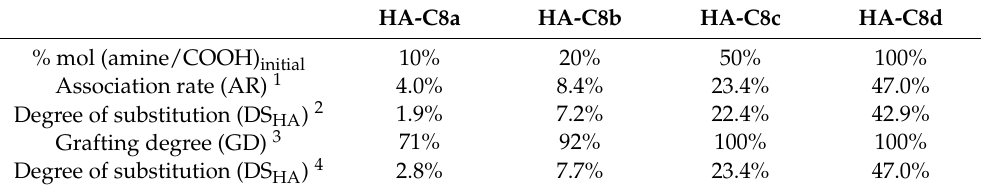
Figure 2. 1 H NMR spectra of octylamine functionalized HA: Hap , HA-C8a , HA-C8b , HA-C8c , and HA-C8d ) (500 MHz, 318 K, DMSO d 6 , and DMSO peak is omitted for clarity). Table 1. Degrees of substitution of HA functionalized with n